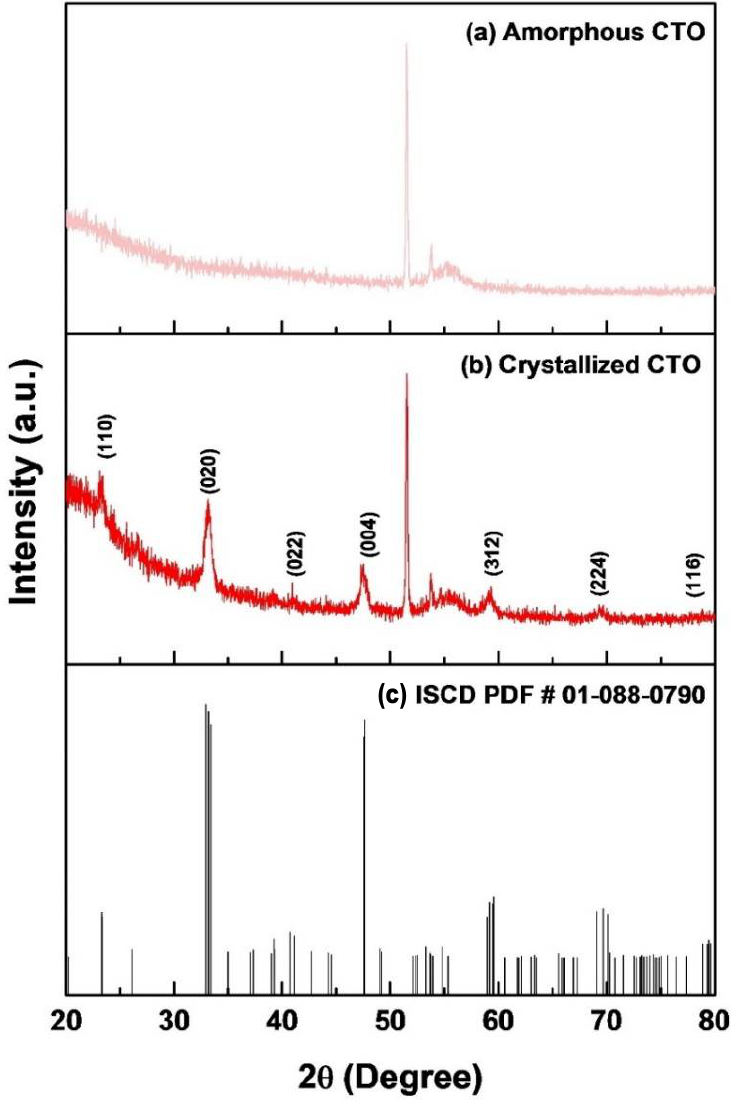
Figure 3. XRD pattern of ( a ) amorphous CTO film, ( b ) crystallized CTO film, and ( c ) the reference for the plane of CTO .